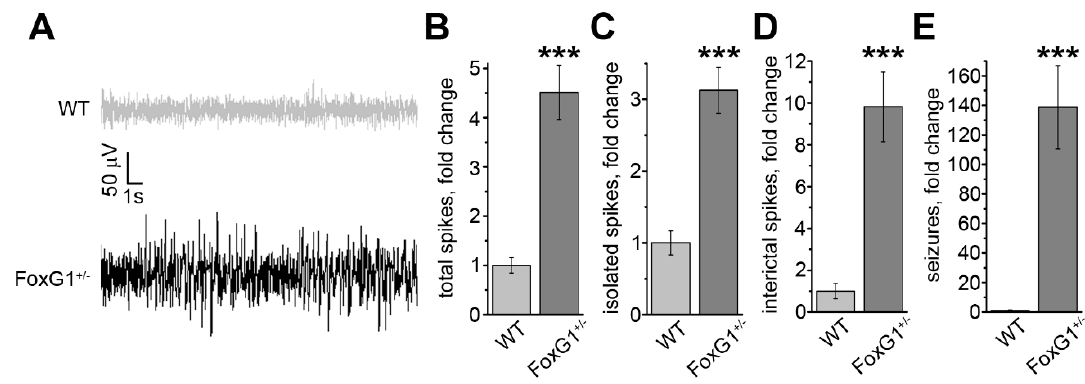
Figure 1. Local Field Potential (LFP) recordings of epileptiform activity in the primary motor cortex of FoxG1 +/ − mice. ( A ) Representative traces of LFP recordings in wild type controls (WT) and FoxG1 +/ − mice; ( B ) increase in the total number of high-amplitude spikes in FoxG1 +/ − mice (WT, n = 7; FoxG1 +/ − , n = 7; Student’s t -test, *** p < 0.001); ( C ) increased high-amplitude spikes in FoxG1 +/ − mice (WT, n = 7; FoxG1 +/ − , n = 7; Student’s t -test, *** p < 0.001); ( D ) increased interictal events in FoxG1 +/ − mice (WT, n = 7; FoxG1 +/ − , n = 7; Student’s t -test, *** p < 0.001); ( E ) increased number of electrographic seizures in FoxG1 +/ − mice (WT, n = 7; FoxG1 +/ − , n = 7; Student’s t -test, *** p <